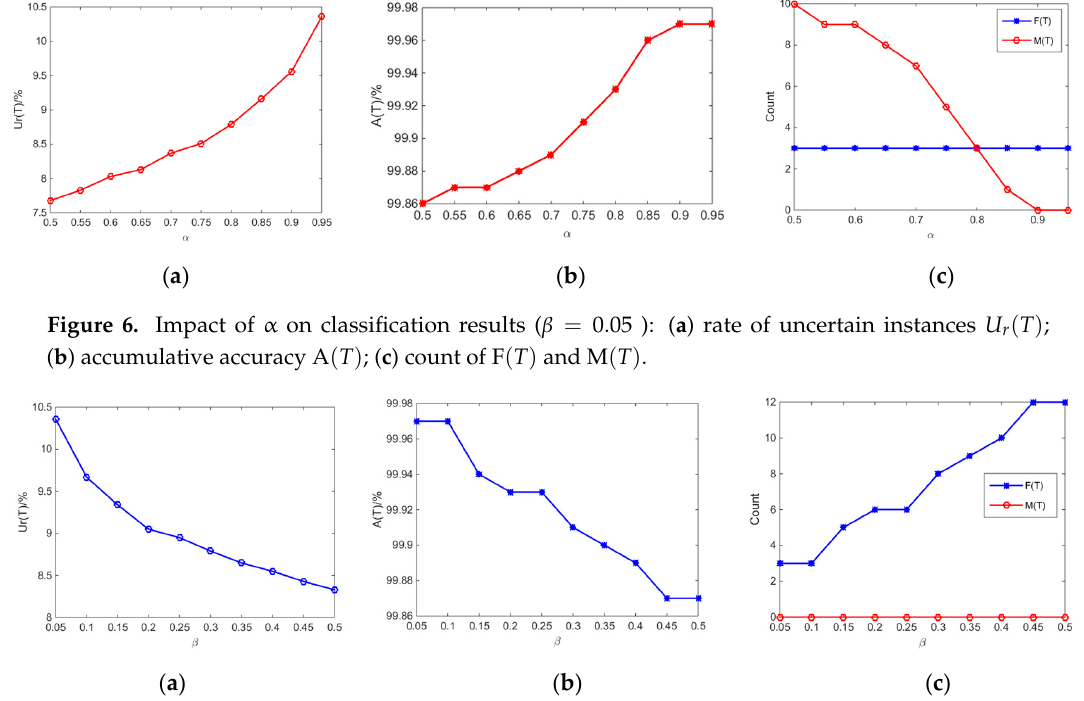
Figure 7. Impact of β on classification results ( α = 0.95): ( a ) rate of uncertain instances U r ( T ) ; ( b ) accumulative accuracy A ( T ) ; ( c ) count of F ( T ) and M ( T ) . Table 3. Prediction results of the hierarchical self-adaptive method.